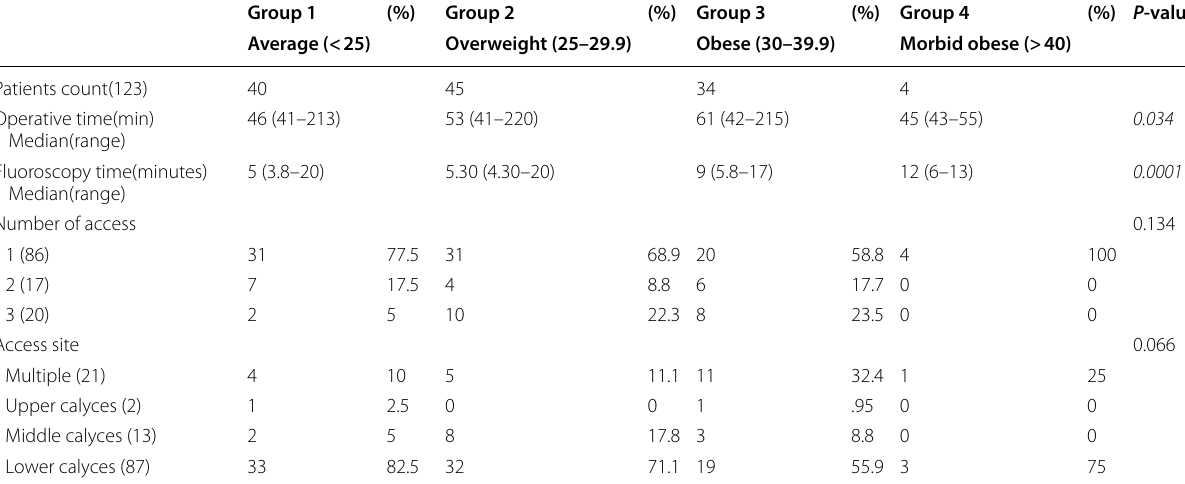
Table 2 Analysis of intra-operative